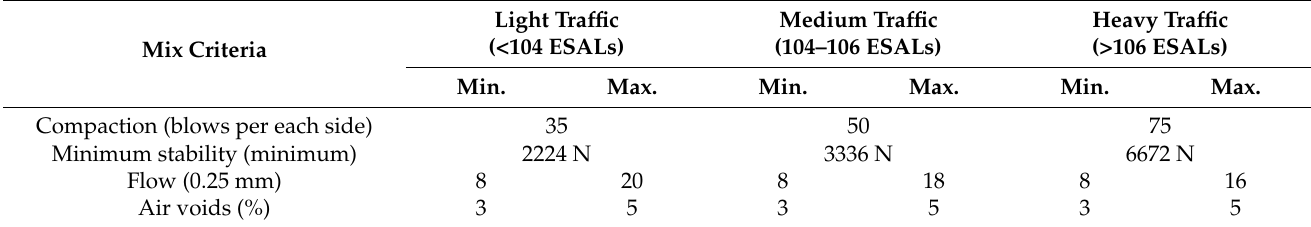
Table 4. Marshall mix design acceptance rates